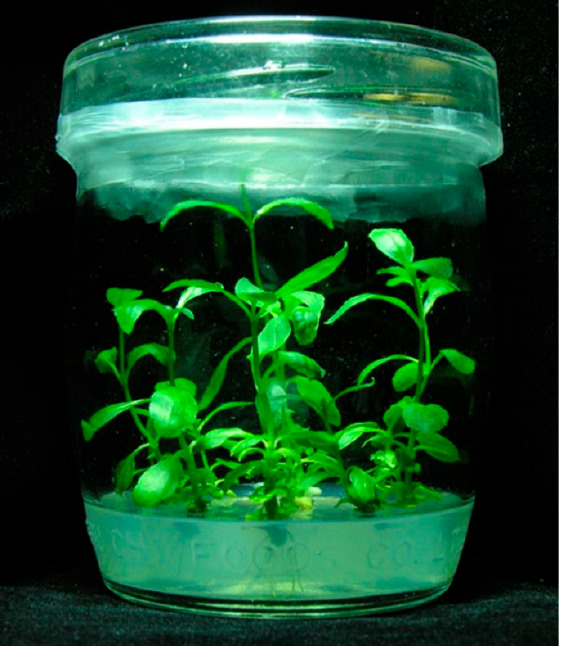
Figure 1. In vitro propagation of Wedelia chinensis . Sterile nodal segments were transferred to MS basal medium supplemented with 2% sucrose and grown in a growth chamber for one to two months. Roots were observed at the bottom of the container.